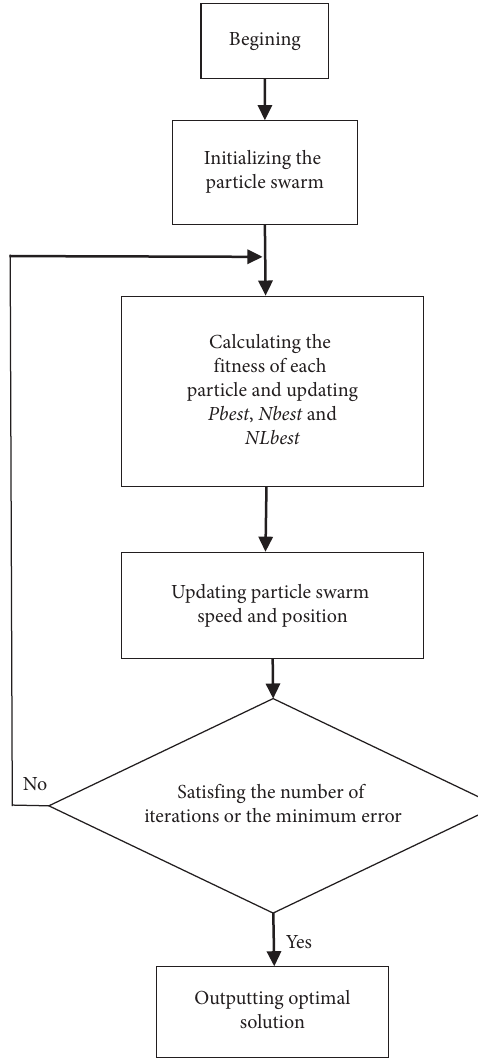
Figure 2: Te solution fow chart of the PSO